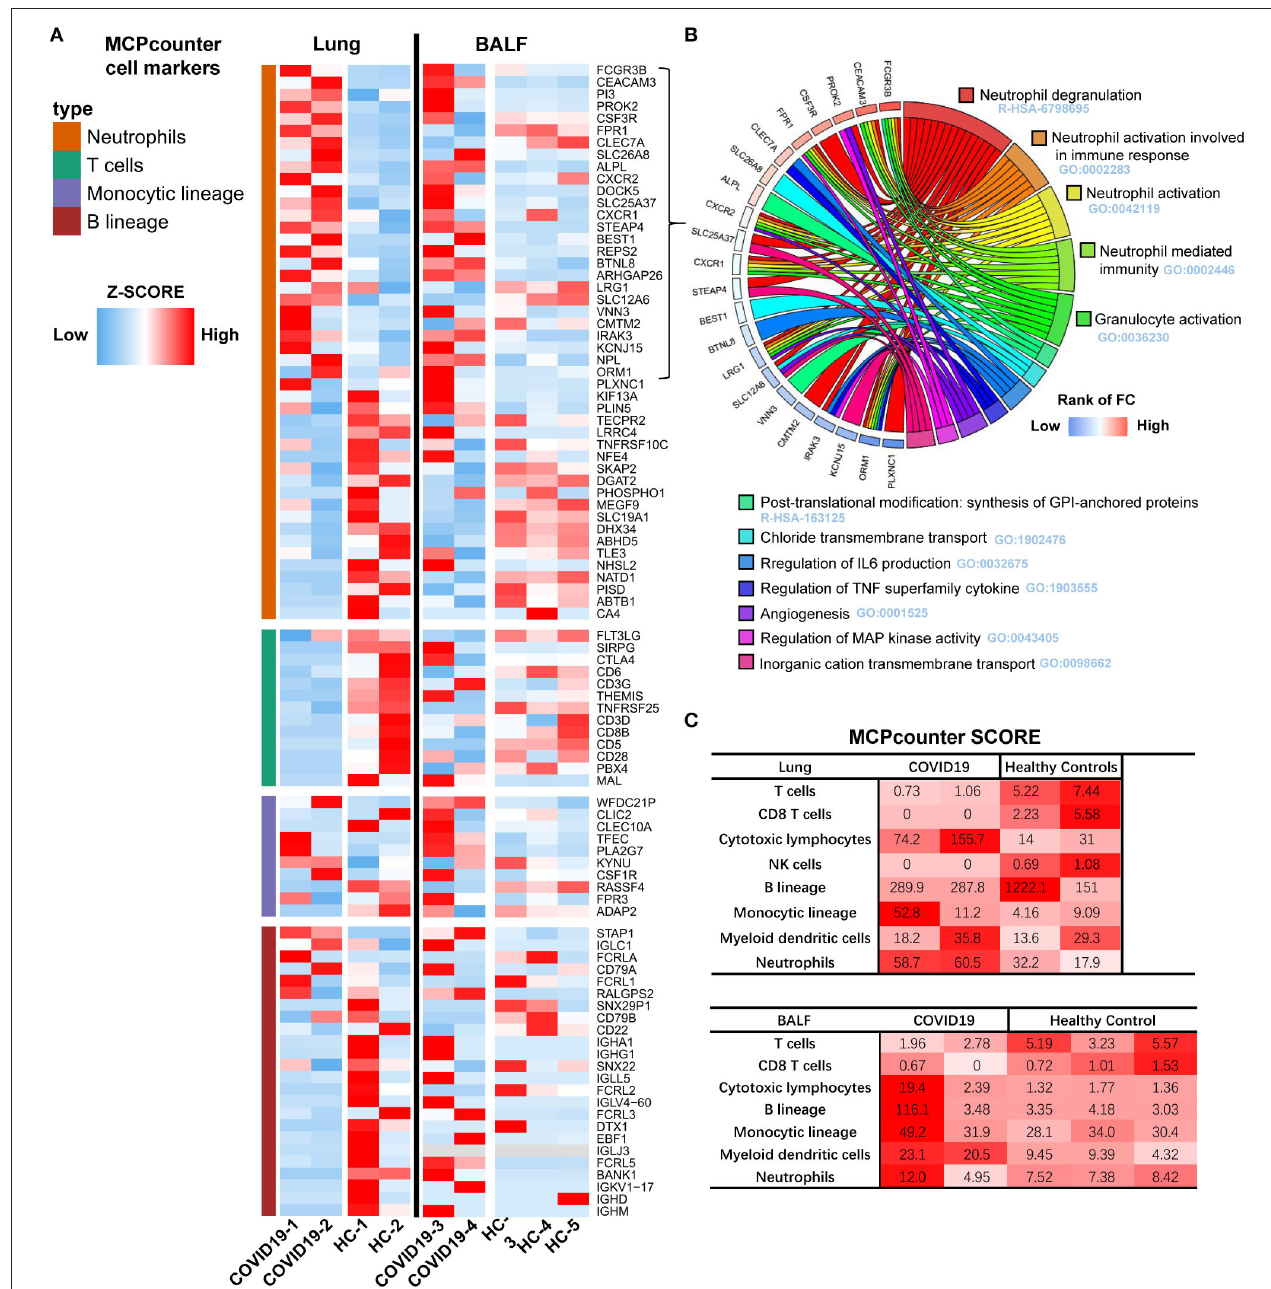
FIGURE 4 | Transcriptome analysis of the lung and BALF in COVID-19 patient. (A) Marker genes from Microenvironment Cell Populations-counter (MCP-counter) were used to identify of Neutrophils, T cells, Monocytes, and B cells in both Lung and BALF samples of COVID-19 patients and healthy controls, respectively. The RNA-seq data TPM are shown in a scaled heatmap. (B) Circle plots for functional enrichment analysis of 29 marker genes of Neutrophils. (C) The absolute abundance of immune cell subpopulations as scores in COVID-19 patients and healthy cases.